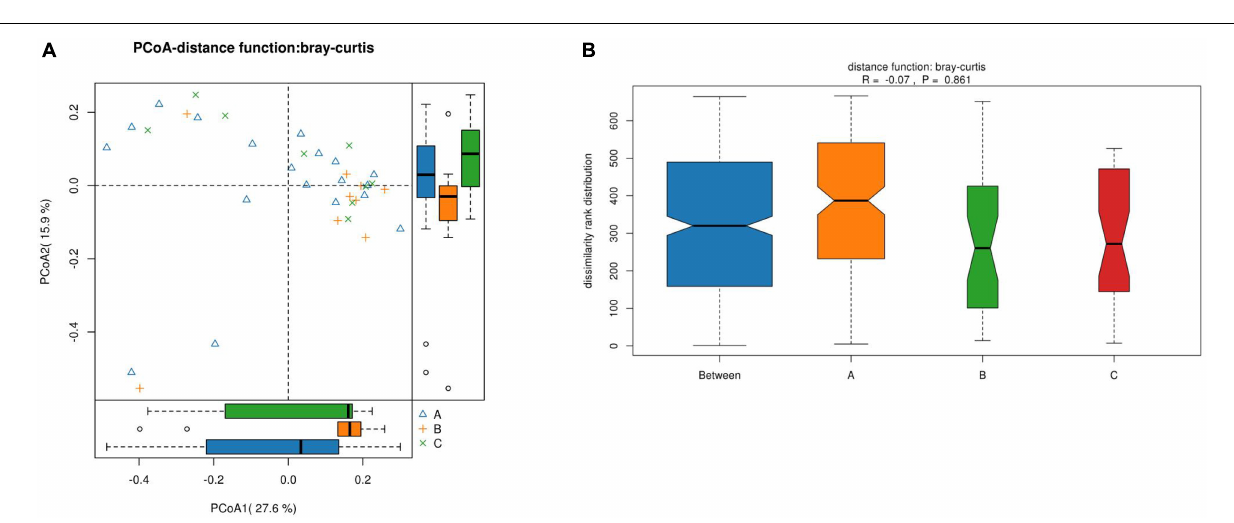
FIGURE 6 | The β -diversity of the intestinal microbiota of the children in the three groups. (A) Comparison of the similarity of species between samples by the distance between the samples in the figure; the greater the distance, the greater the difference. (B) Between represents the difference between groups, while the other items are within groups. The greater the distance, the greater the difference, and the thickness represents the sample